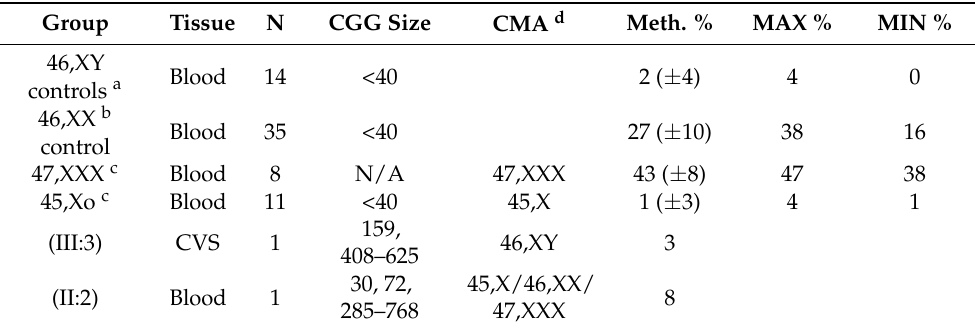
Table 1. Comparisons of the CpG10-12 FREE2 methylation for the male CVS and proband blood with the sex chromosome aneuploidy, typically developing female and male reference cohorts from earlier studies